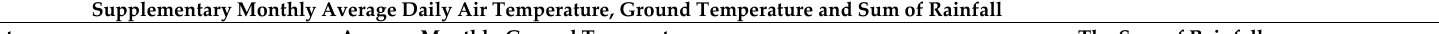
Table 3. Monthly average daily air temperature, ground temperature, and sum of rainfall across the thirteen environments where experiments with barley were conducted (2016–2018).